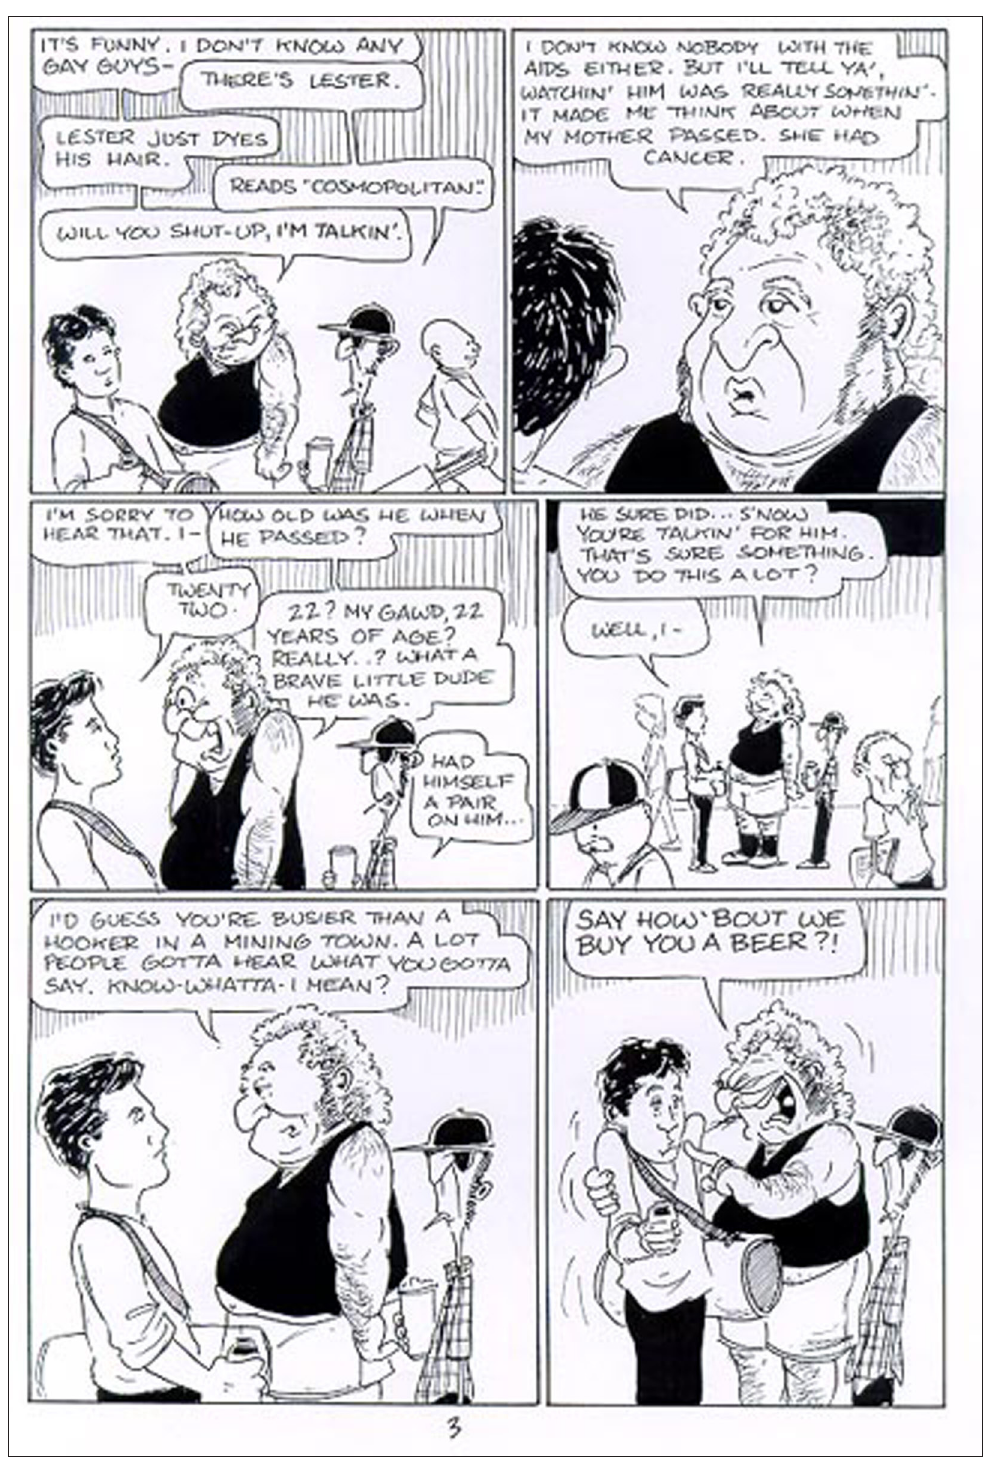
Figure 3: A moment of awkward sincerity, excised from the final book. This sequence by Judd Winick originally appeared on a former Henry Holt mini-site to support the release of the first edition of Pedro and Me . Judd Winick, Henry Holt defunct Pedro and Me site, still available at https://web.archive.org/web/20071018075021/http://www.captionbox. net/pedro/cutpages1.html. © 2000 Judd